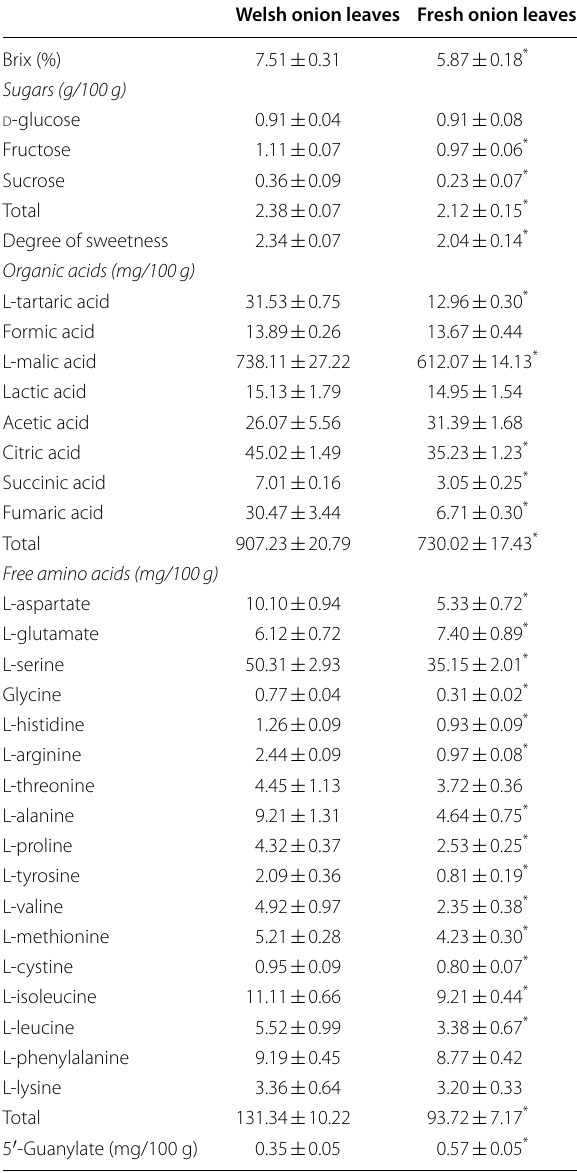
Values are the mean SD ( n 5) * p < 0.05 (Welch’s t test), compared between ± = Welsh onion leaves and flesh onion leaves in each